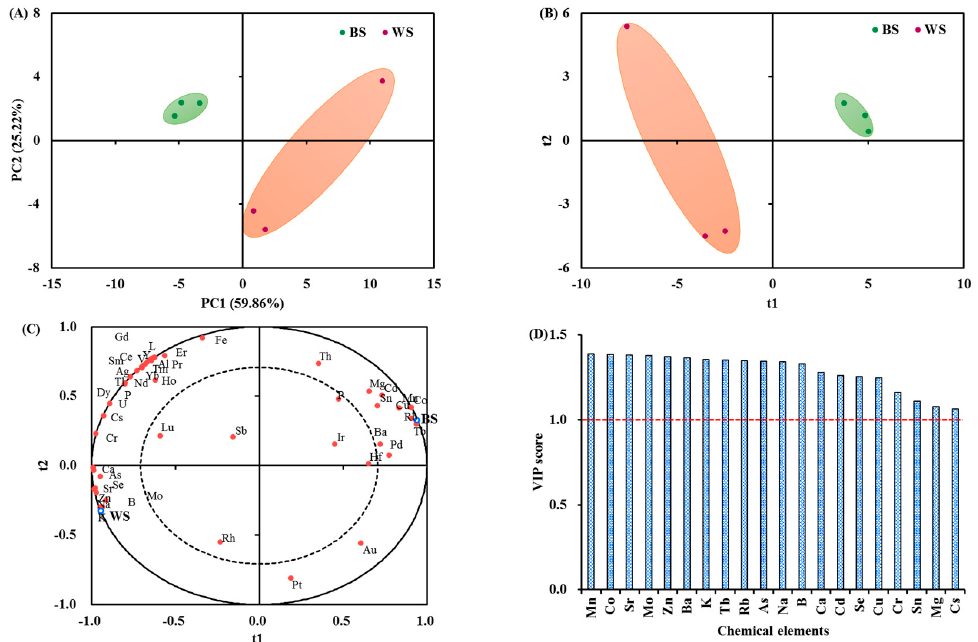
Figure 1. ( A ) Score plot of PCA performed on the chemical elements. ( B ) Score plot of PLS-DA performed on the chemical element data (R 2 X = 0.91, R 2 Y = 1.00 and Q 2 = 0.99). ( C ) Correlation circle between chemical elements and sesame seeds. ( D ) Bar chart of the VIP scores of the candidate chemical elements for discriminating the two groups of sesame seeds. BS, black sesame seeds; WS, white sesame seeds; VIP, variable importance in projection.